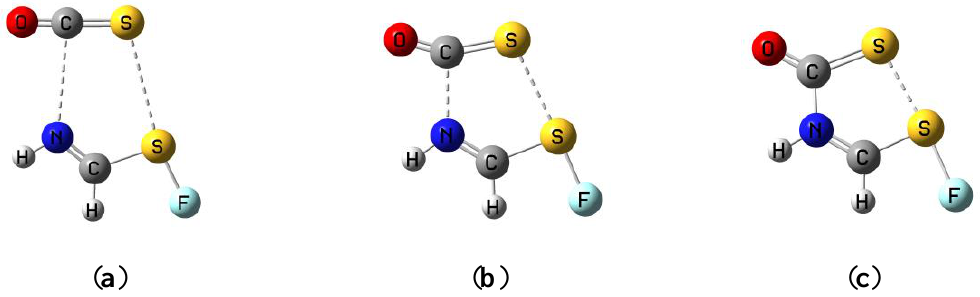
Figure 3. HN(CH)SF:SCO ( a ) complex; ( b ) transition structure; and ( c ) molecule with C s symmetry.